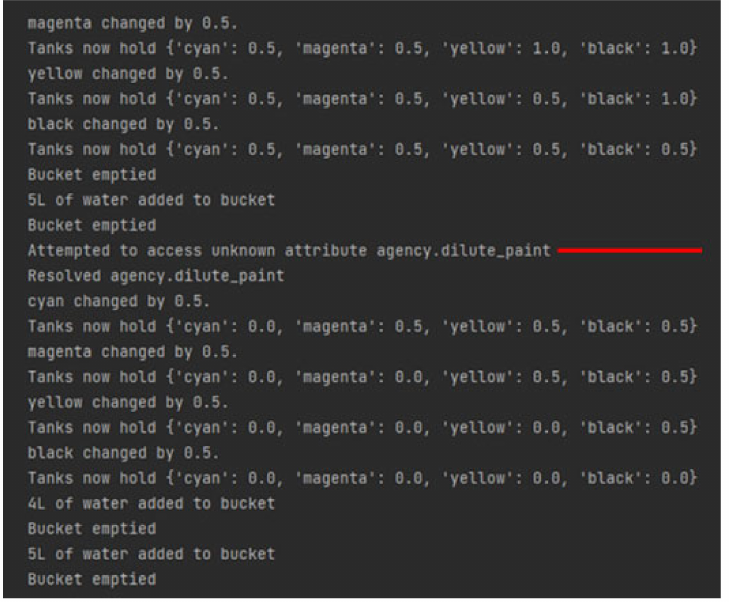
Figure 10. Trace output from the paint-mixing robot showing the intervention of the ItmPy aspect weaver (indicated by a red line).